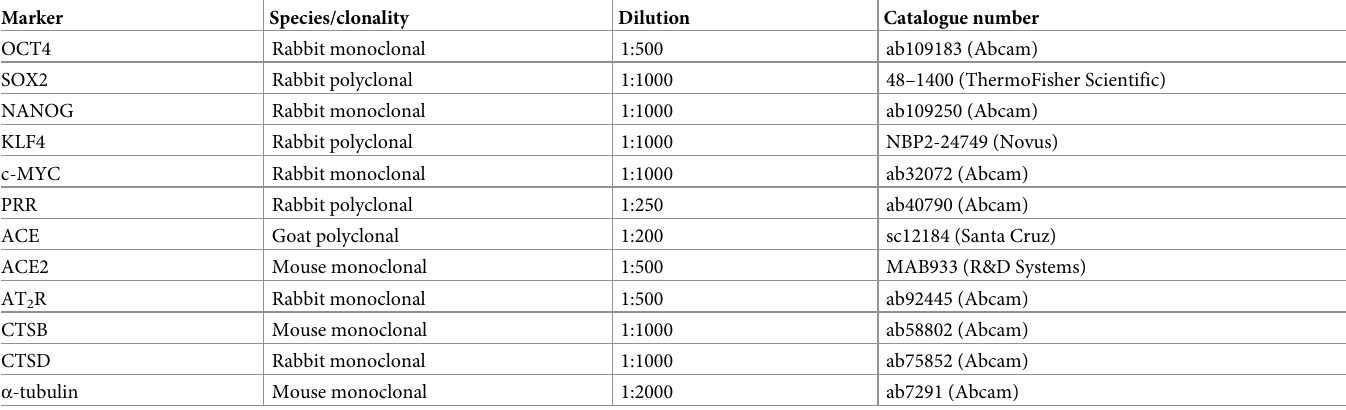
Table 2. Primary antibodies used for western